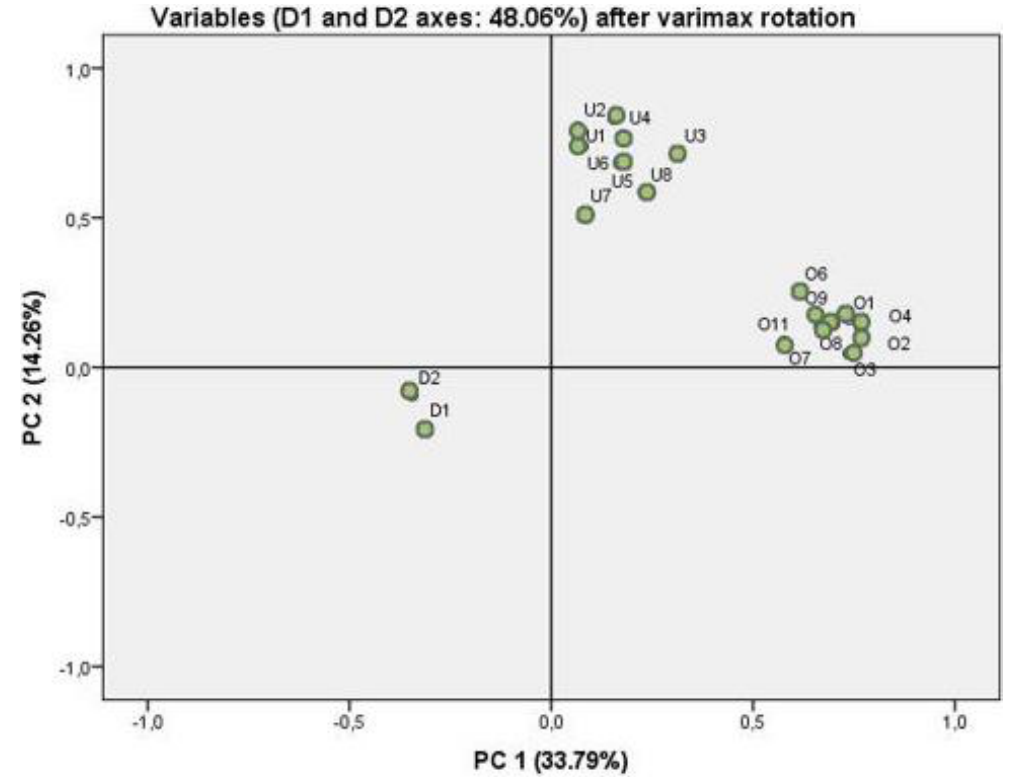
Figure 1 - Loadings for the PC1–PC2 dimensions, after varimax normalized rotation, of the 20 variables selected to